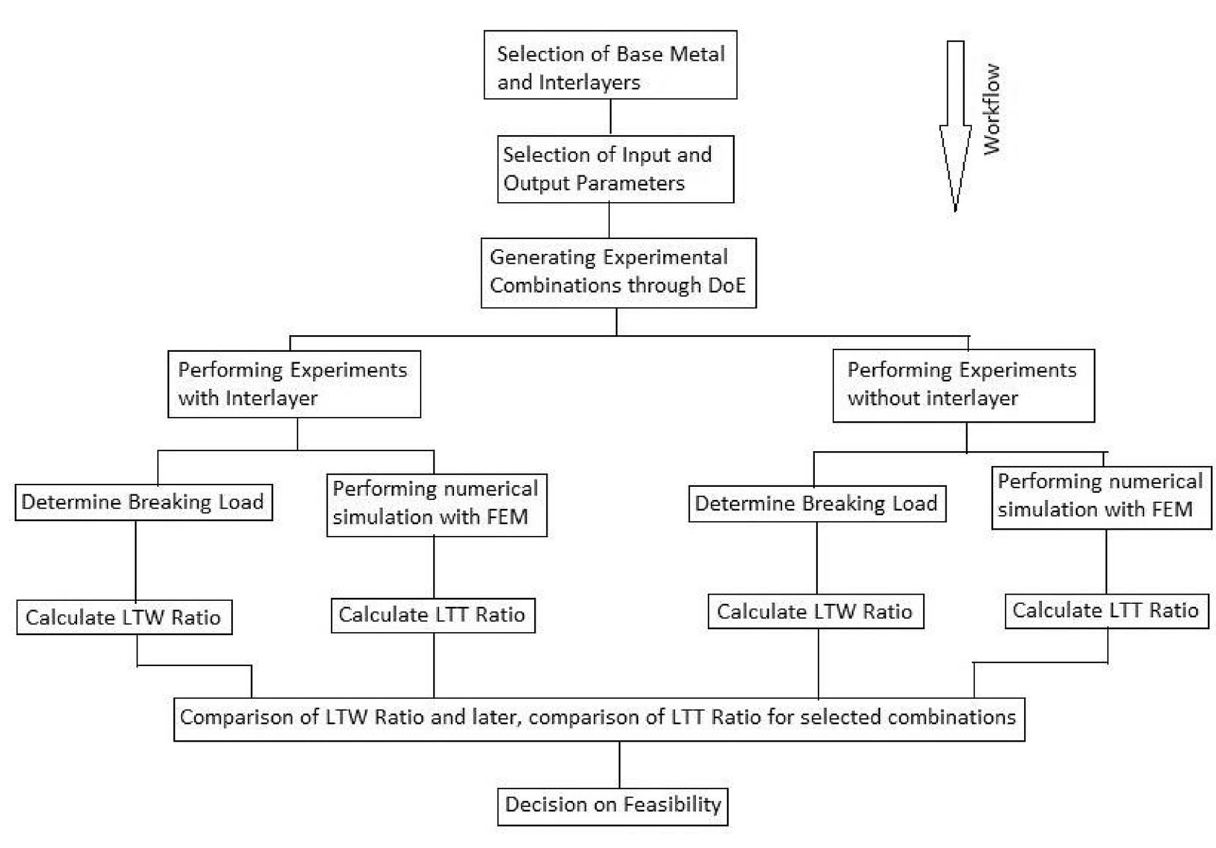
Fig. 1 Methodology Fig. 2 Presumed location of Spot Weld and location